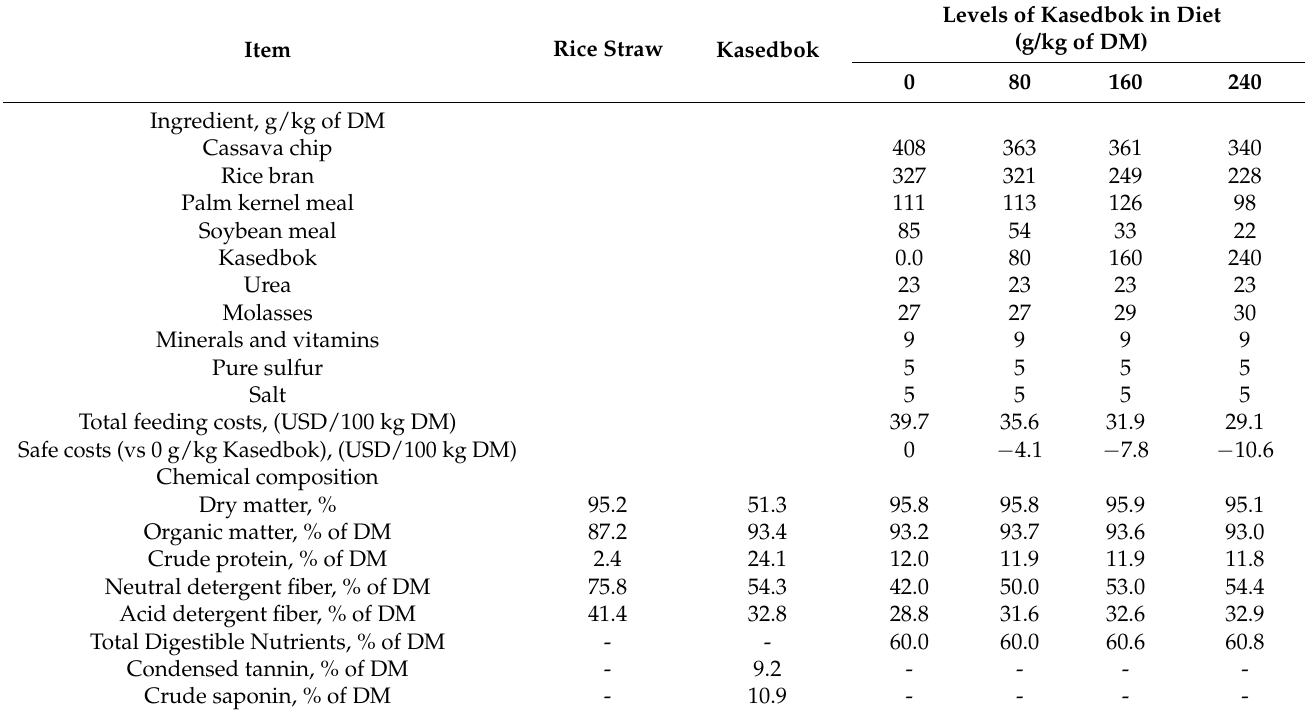
Table 1. Ingredients and chemical compositions of the